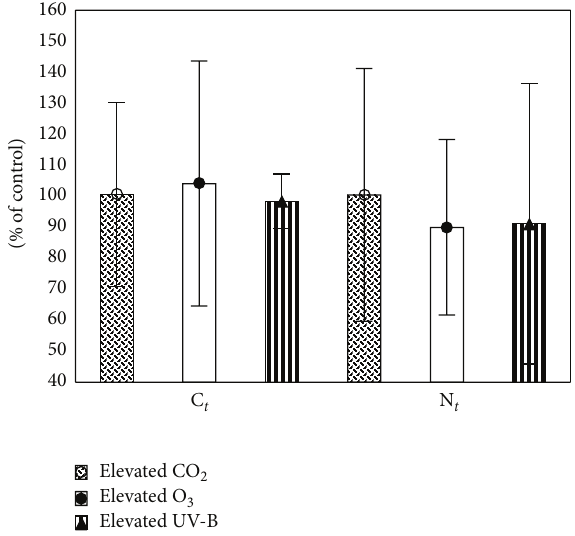
Figure 1: Effect of elevated CO 2 , O 3 , and UV-B on C (recalculated from [30–33]). The values are expressed in % of control = 100% which represent ambient CO 2 , O 3 , or UV-B (mean ± SD).